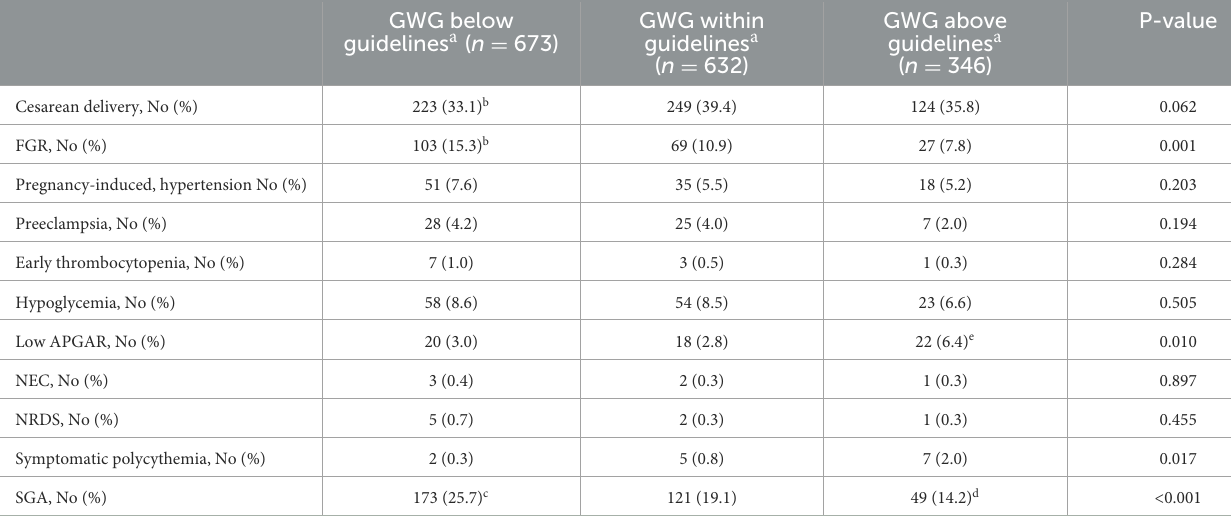
TABLE 4 Maternal and neonatal outcomes by maternal weight gain category ( N = 1,651). GWG below guidelines a ( n = 673)